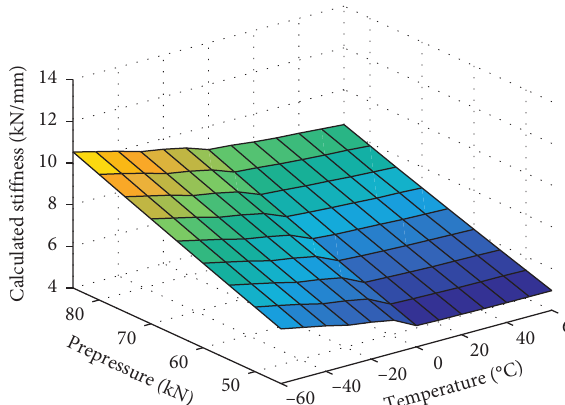
Figure 7: Surface diagram of calculated